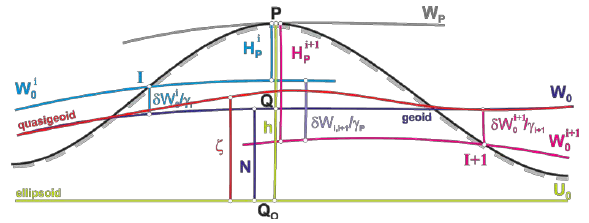
Figure 1. Height datum